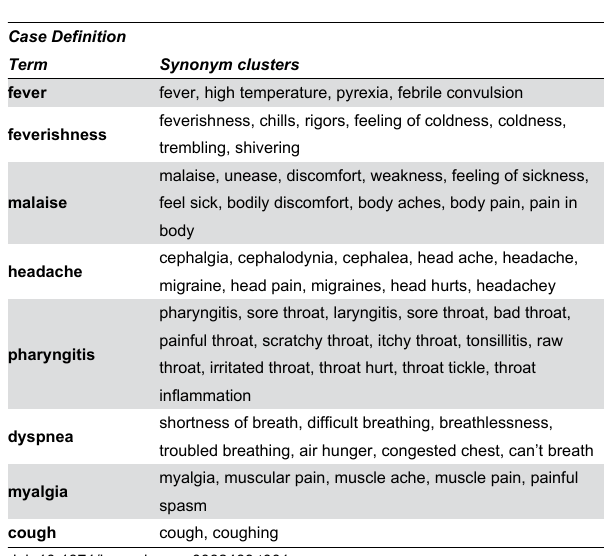
Table 1. Terms extracted from ECDC influenza case definition and synonyms identified by the